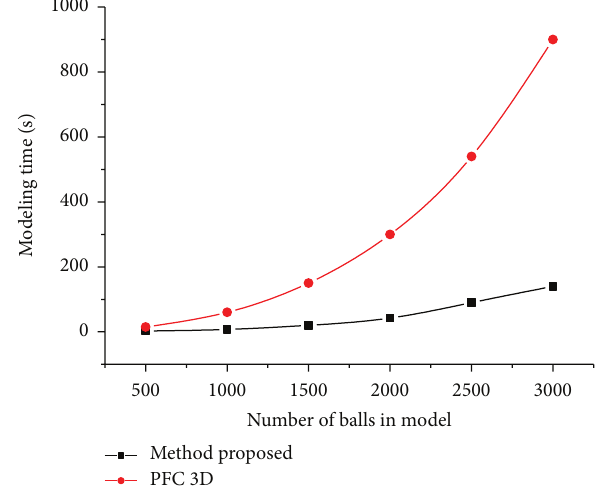
Figure 4: Comparison of the modeling time between PFC 3D and the method proposed in this